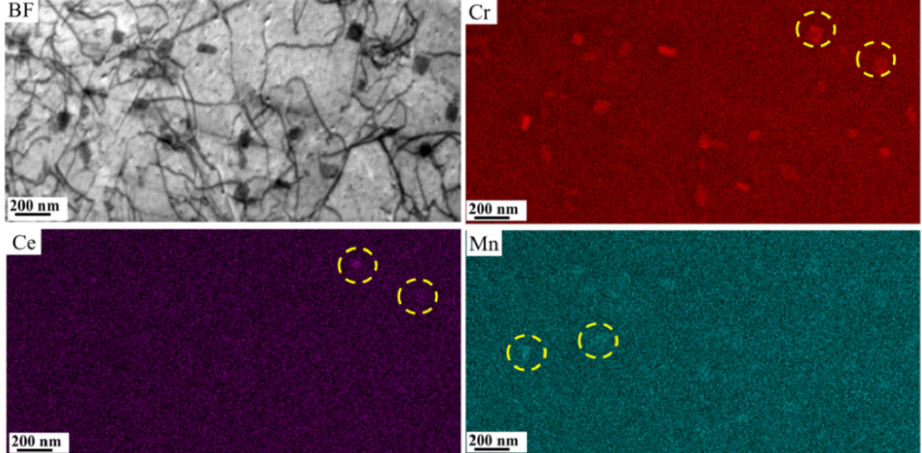
Figure 14. EDS of the grain boundary of the creep sample in BM.